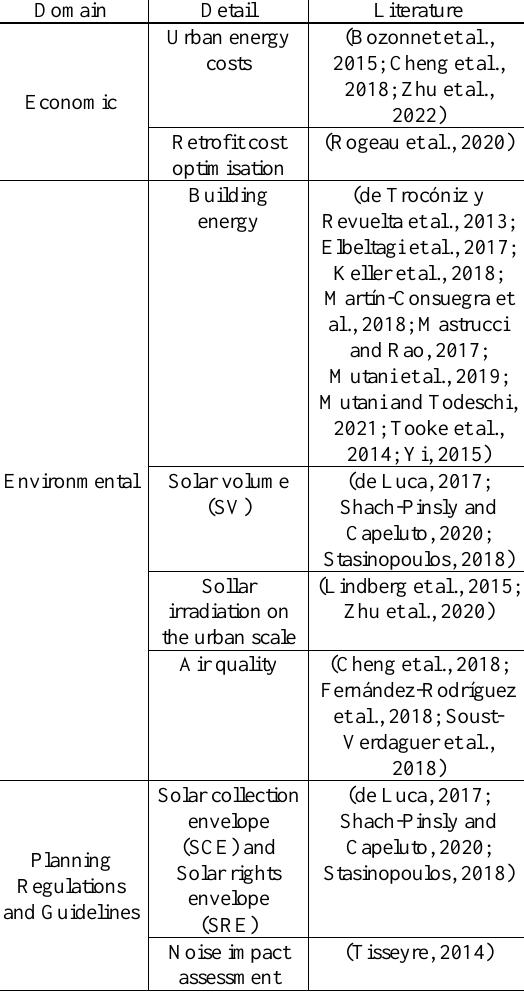
Table 2 . Impact analysis of the 3D city and building models in urban planning.